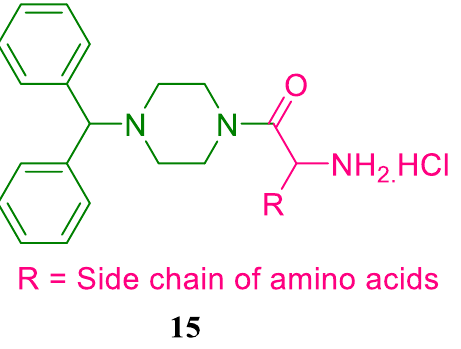
Figure 23. Amino acids-diphenylmethylpiperazine hybrid molecules.